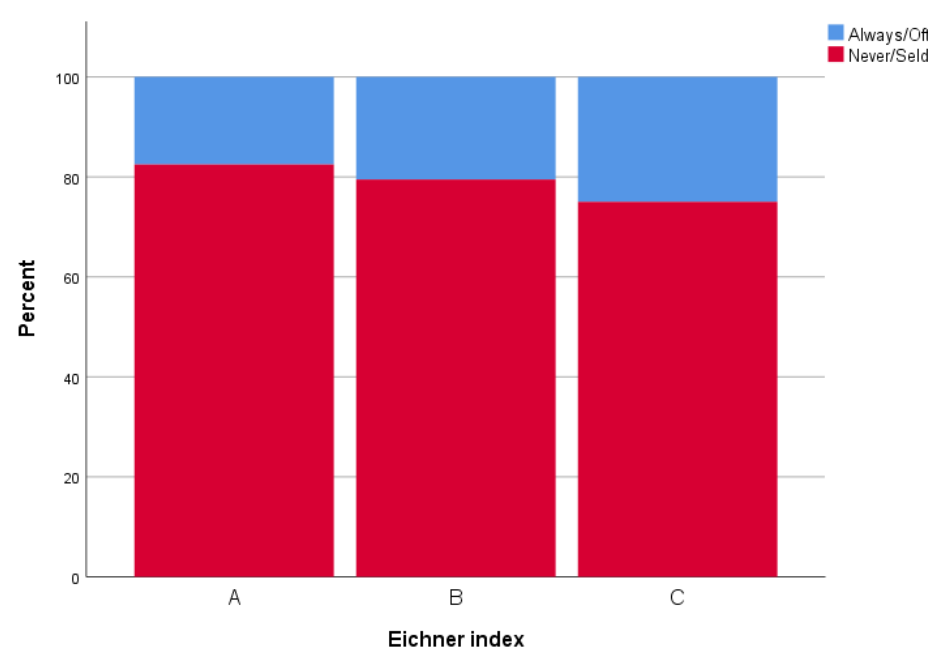
Figure 3. How often did you limit the kinds or amounts of food you eat because of problems with your teeth or dentures? Participants grouped according to the Eichner index, while using dentures, which measures number of occluding teeth. ( A ) = four occluding zones, ( B ) = one to three occluding zones or presence of occlusal contacts frontally, and ( C ) = no occluding teeth. Among those with occlusal contacts in all four posterior support zones (Eichner group A), 93% answered “ never/seldom” to the question “ How often did you limit the kinds or amounts of food you eat because of problems with your teeth or dentures? ” from GOHAI. In the group with no posterior occlusal contacts at all (Eichner group C), 79% answered “ never/seldom” to this question. Similarly, 90% of those belonging to group A rated their ability to chew solid food to be “good,” as compared to 77% in group C.